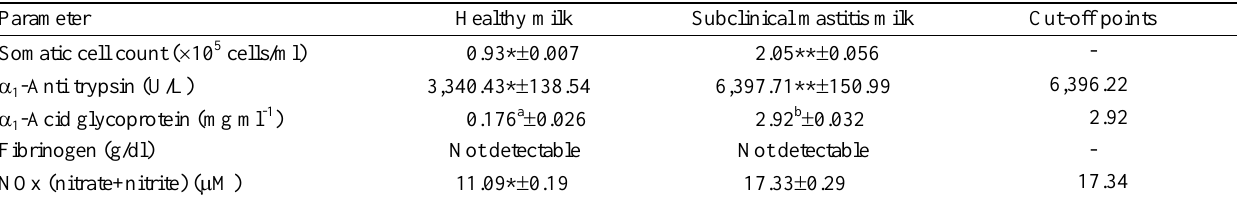
Table 3. Mean  SE of SCC, acute phase proteins and NOx in milk from healthy and subclinical mastitis (irrespective of the causative agent) in riverine buffalo to decide the threshold limit (n =